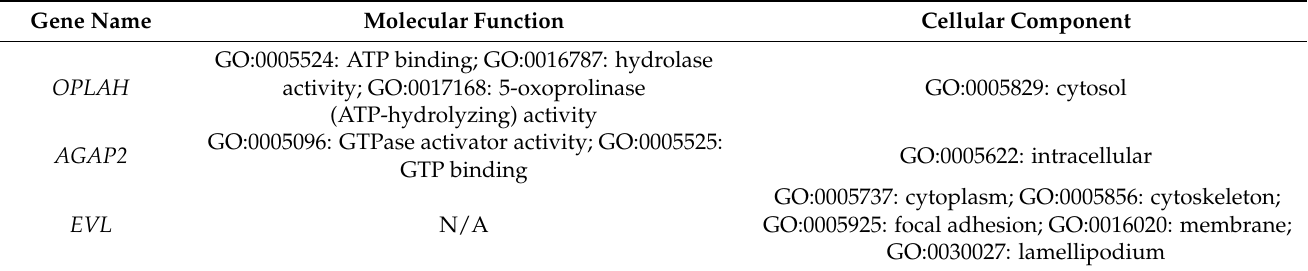
Table 5. Gene ontology DMRs identified in CON vs. RES